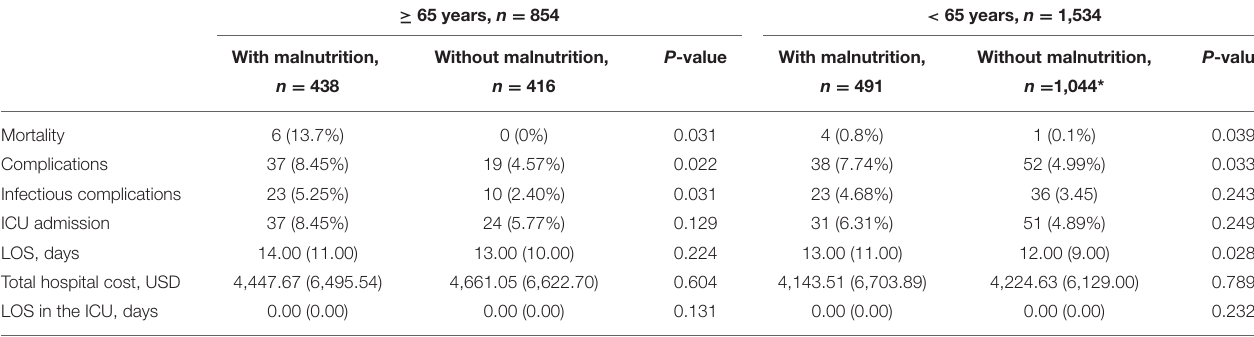
TABLE 3 | The association between GLIM defined malnutrition and clinical outcomes. ≥ 65 years, n = 854 With malnutrition, Without malnutrition, P -value With malnutrition,